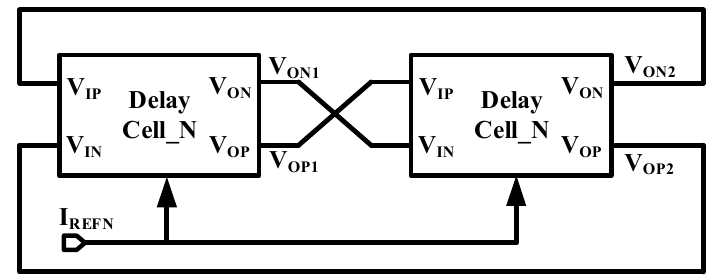
Figure 2. Proposed CMOS thyristor based voltage controlled oscillator (VCO).